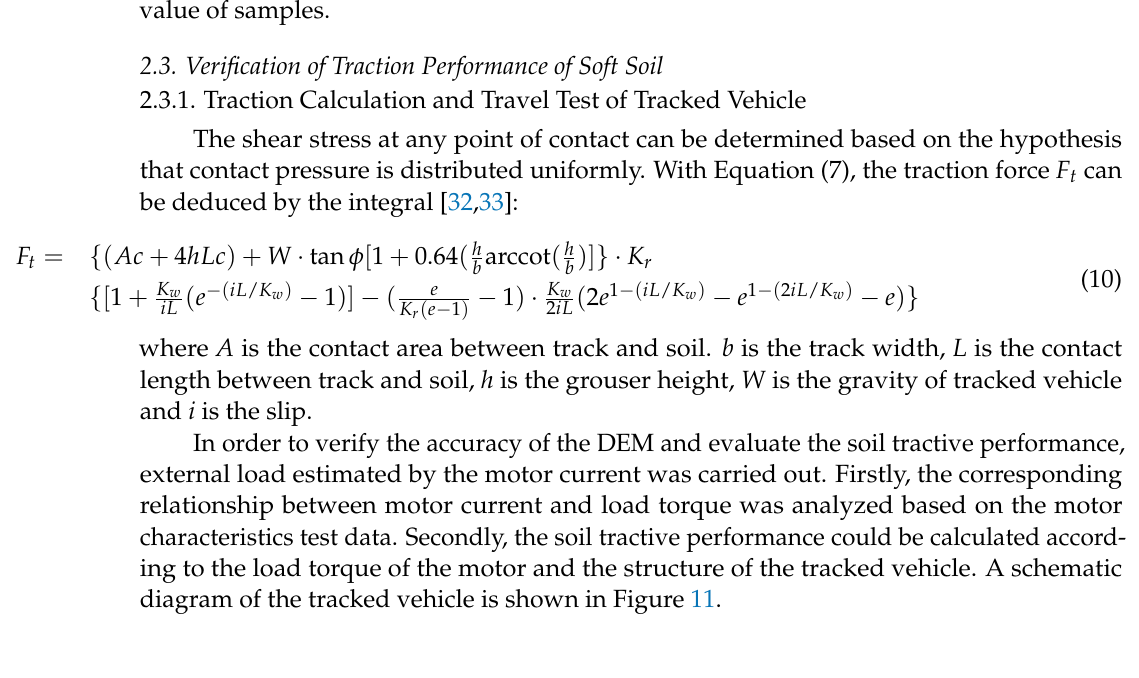
Figure 10. Shear process of track segment and clay in the DEM simulation.